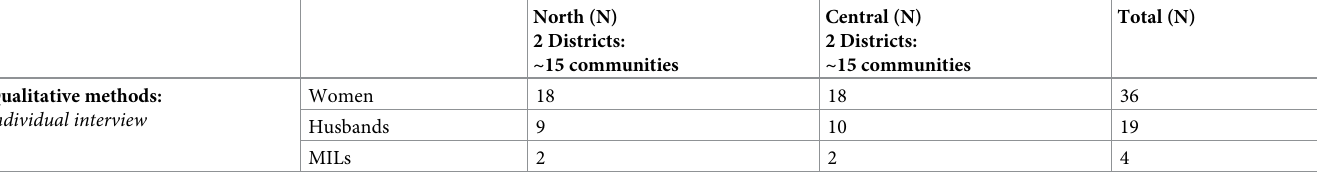
Table 1. Sample size of